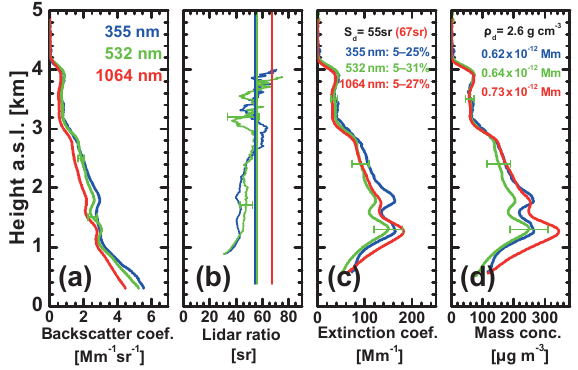
Figure 8. Dust extinction and mass concentration profiles (panels c and d ) obtained by applying the one-step POLIPHON method to triple-wavelength polarization lidar observations. (a) Measured particle backscatter coefficients (as in Fig. 7), (b) Raman-lidar- derived extinction-to-backscatter ratios (355nm in blue, 532nm in green) for the 3h period in Fig. 5, (c) derived dust (only) extinc- tion coefficients, and (d) dust mass concentrations. In the one-step POLIPHON data analysis (Sect. 4.1) we used characteristic non- dust (5%) and dust depolarization ratios (25, 31, and 27%; also given as numbers in panel c ). The dust extinction coefficients are obtained by multiplying the dust backscatter coefficients with a lidar ratio of 55sr (355, 532nm) and 67sr (1064nm); see vertical lines in panel (b) . The dust extinction coefficients are converted to mass concentrations by means of the conversion factors in Table 2, given as numbers in panel (d) . We assume a dust particle mass density of 2.6gcm − 3 . Error bars show estimated overall retrieval uncertain- ties of 20 (extinction coefficient) and 25% (mass concentration) for